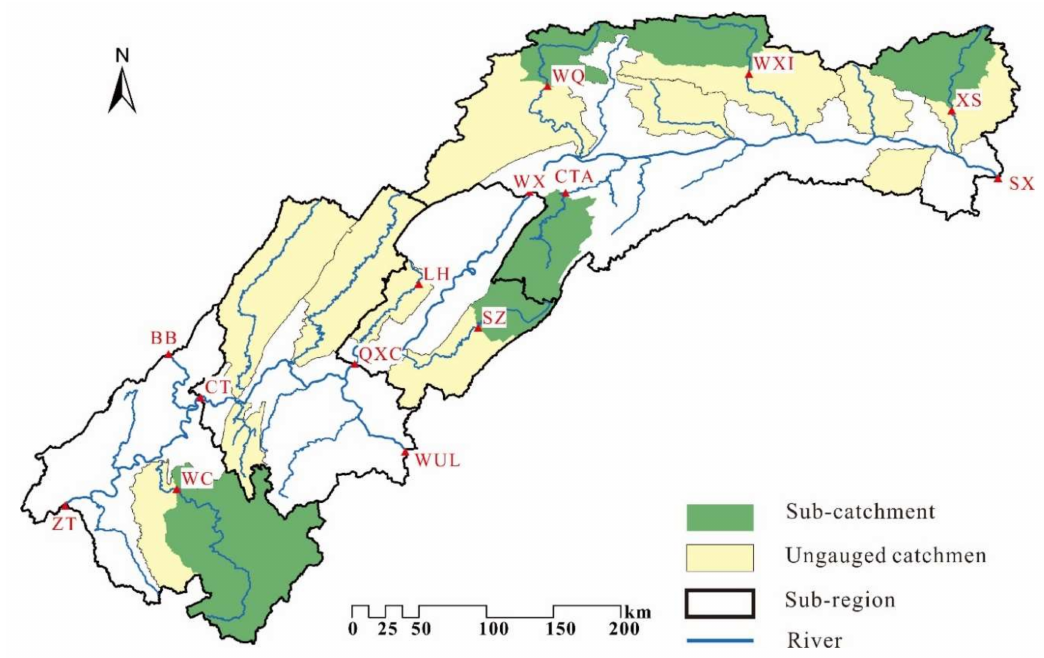
Figure 5. Relative positioning of the sub-catchments and sub-regions. WC, SZ, WQ, CTA, WXI and XS stand for the Wucha, Shizhu, Wenquan, Changtan, Wuxi, and Xingshan hydrometric station